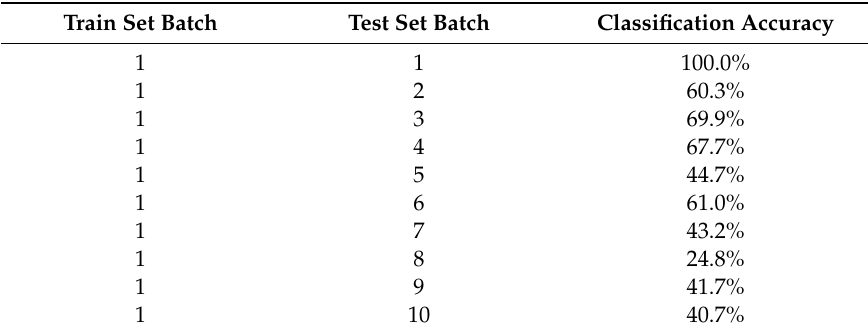
Table 5. Sensor Drift